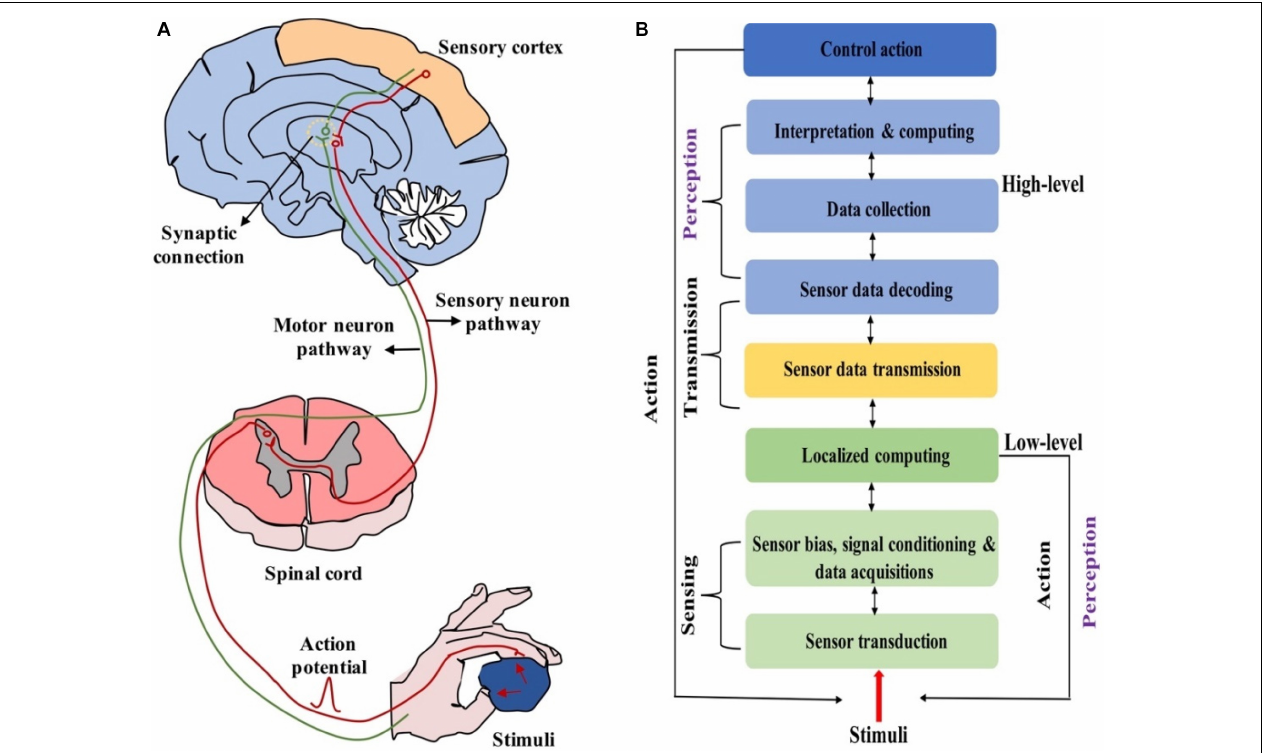
FIGURE 1 | (A) Biologically neural systems for sensing and perception. (B) Hierarchical functional framework of information processing in neuromorphic neural system (adapted from Wang et al., 2020).